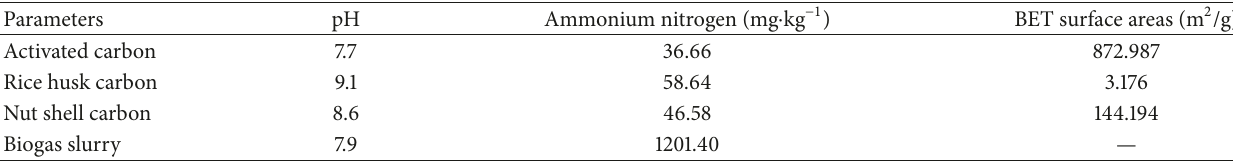
Table 2: Characteristics of biochars and biogas slurry used in this